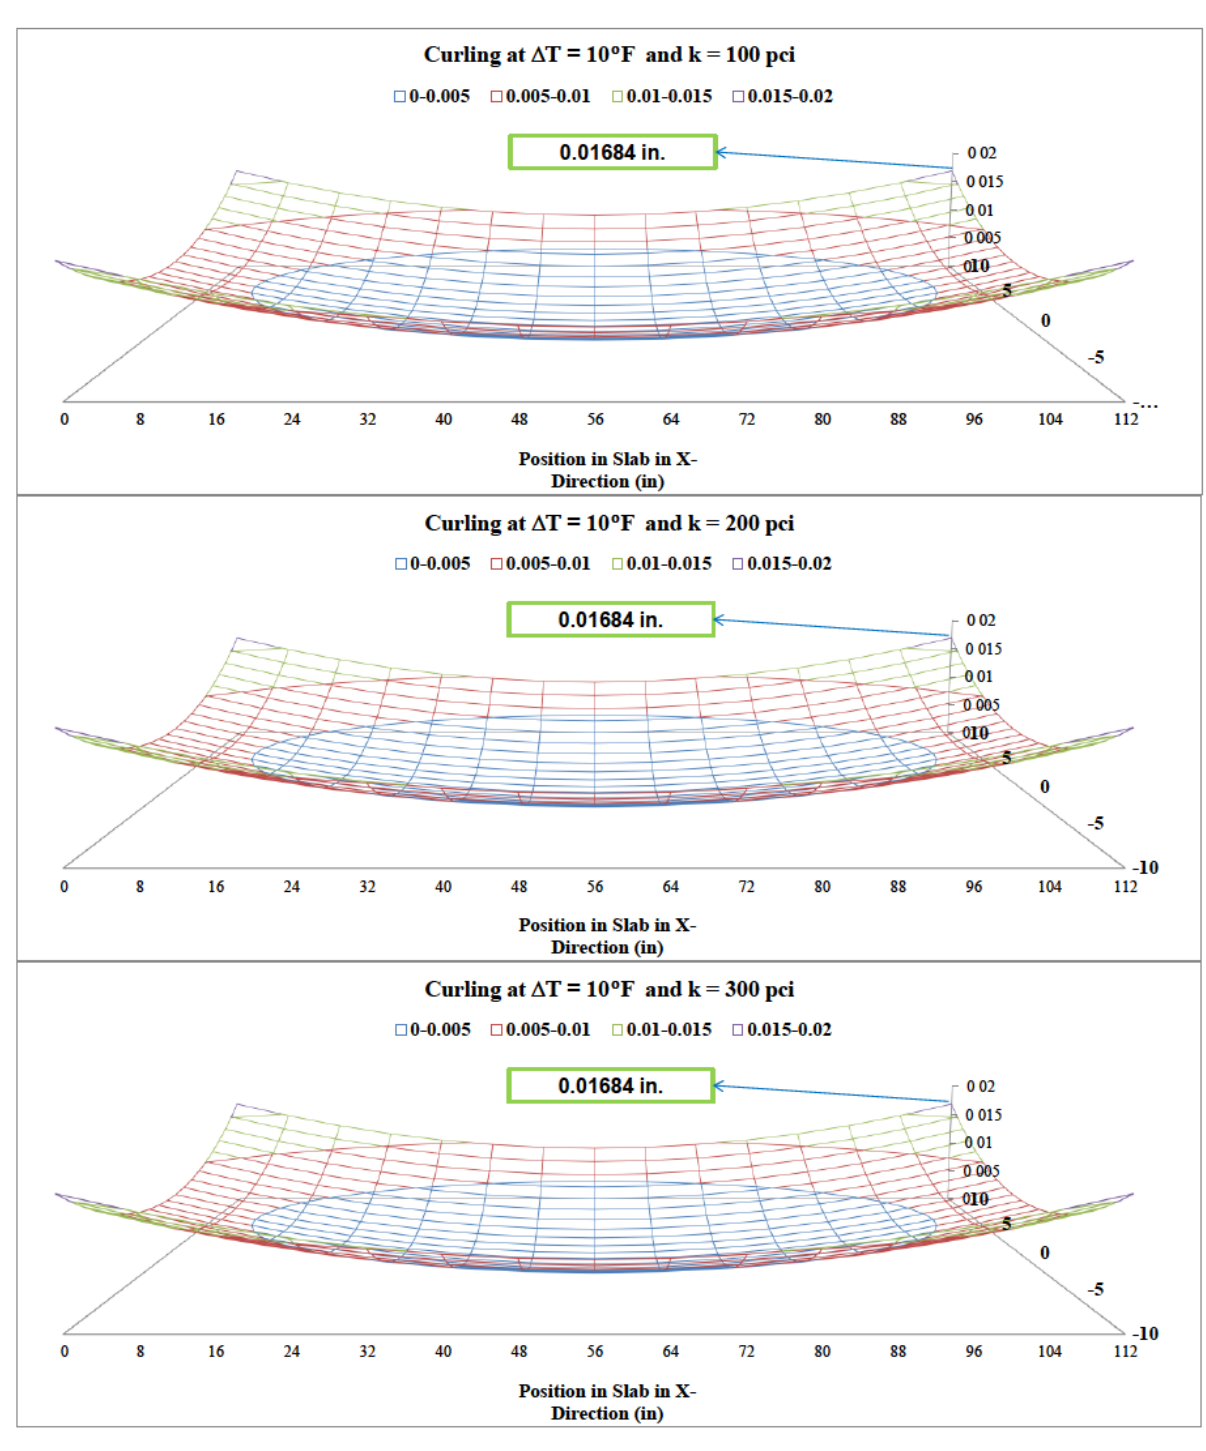
Figure 11: Curling at the same ∆ T = 10 ∘ F with different k-value (100, 200, and 300